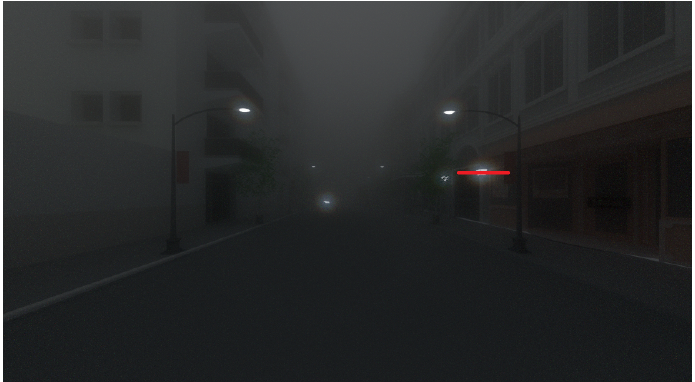
Figure 15. Pixel line (in red) for the urban simulated scene at